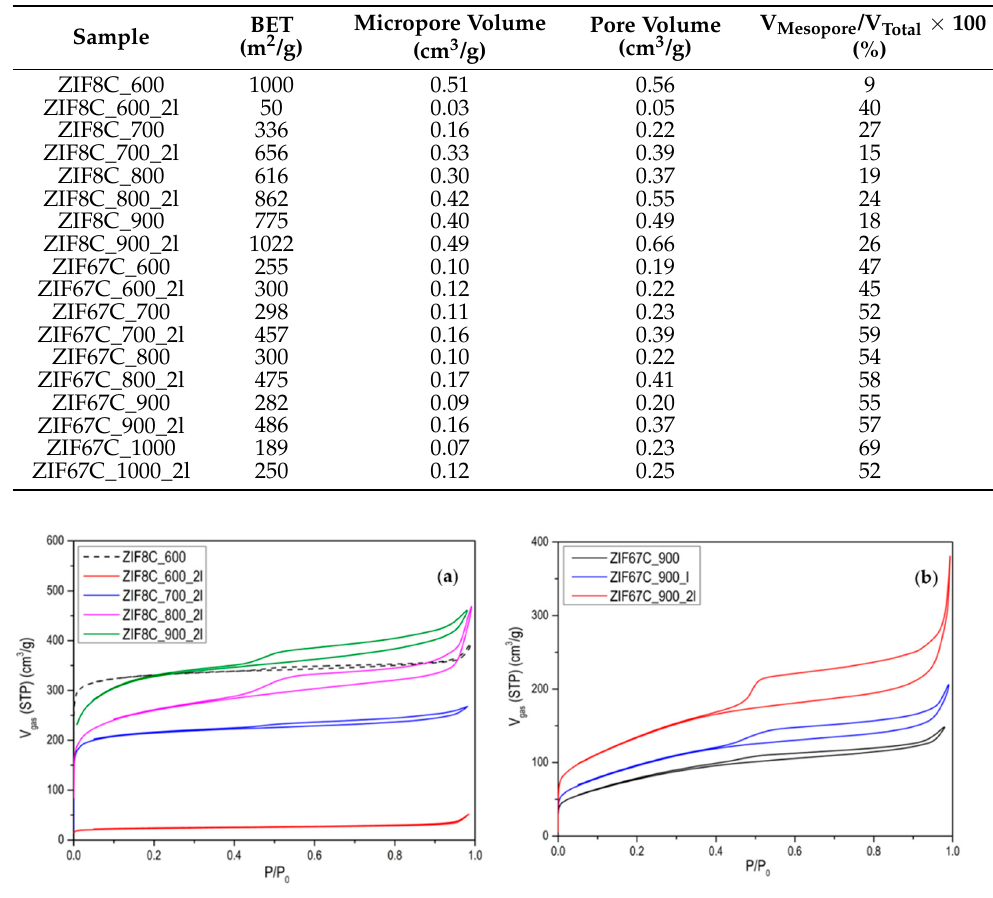
Figure 3. N 2 adsorption isotherms at − 196 °C of ( a ) the activated carbons obtained from ZIF-8; ( b ) the activated carbons obtained from ZIF-67 at 900 °C, and the effect of the washing with HCl. The evolution of activated carbons obtained from ZIF-8 and ZIF-67 show different